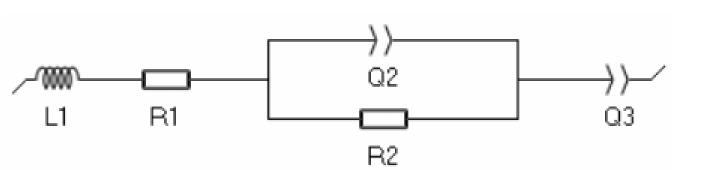
Figure 2. Flowchart of the aging test.